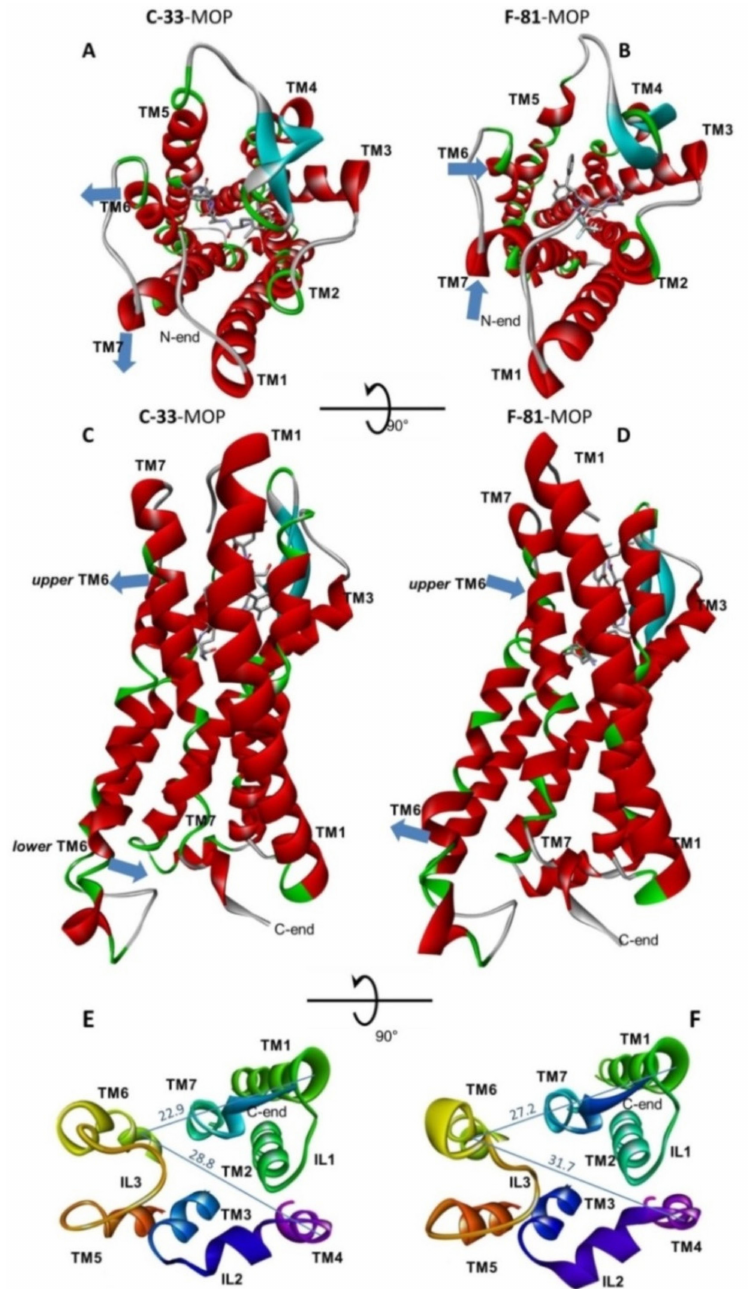
Figure 7. Views of the predicted binding poses of C-33-MOP and F-81-MOP. ( A ) Top views of C-33- MOP and ( B ) of F-81-MOP, showing in particular the different position of TM6 and TM7. ( C ) Side views of C-33-MOP and ( D ) of F-81-MOP, highlighting the inclination of TM6. ( E ) cytosolic ends of the helices and the intracellular loops of C-33-MOP and ( F ) of F-81-MOP; the distances between the C α s of Arg280(TM6)-Arg182(TM4) and Arg280-Tyr91(TM1) are given in Å (these residues have been selected arbitrarily for easy comparison). The cyan arrows indicate the comparatively diverse positions of TM6 and TM7 of the two